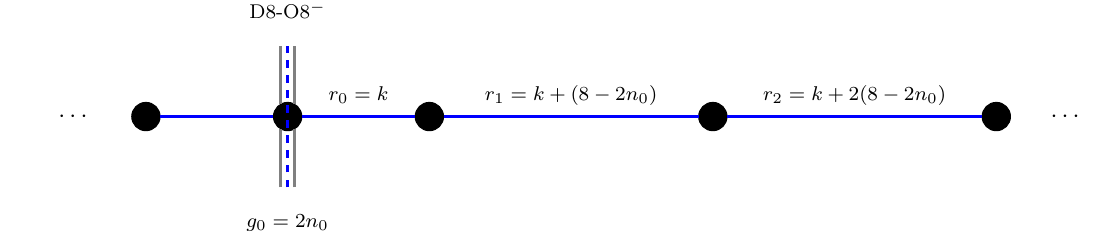
(c) NS5-D6-D8-O8 con(cid:12)guration with O8 + -plane overlaid onto n 0 pairs of D8’s (engineering a (cid:13)avor USp( f 0 = 2 n 0 ) (cid:13)avor symmetry and contributing 2 n 0 full hypermultiplets), and a stuck half-NS5.